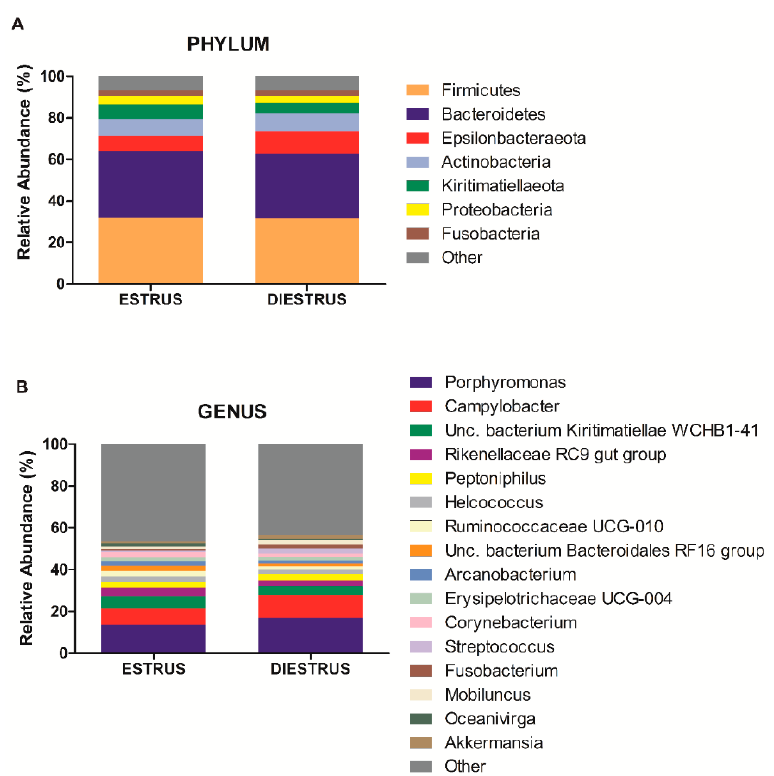
Figure 1. Phylum taxonomic relative abundance in individual mares in estrus and diestrus (only taxa with a mean relative abundance >1.5% at estrus or diestrus are represented). The letters in the x axis correspond to each individual mare.